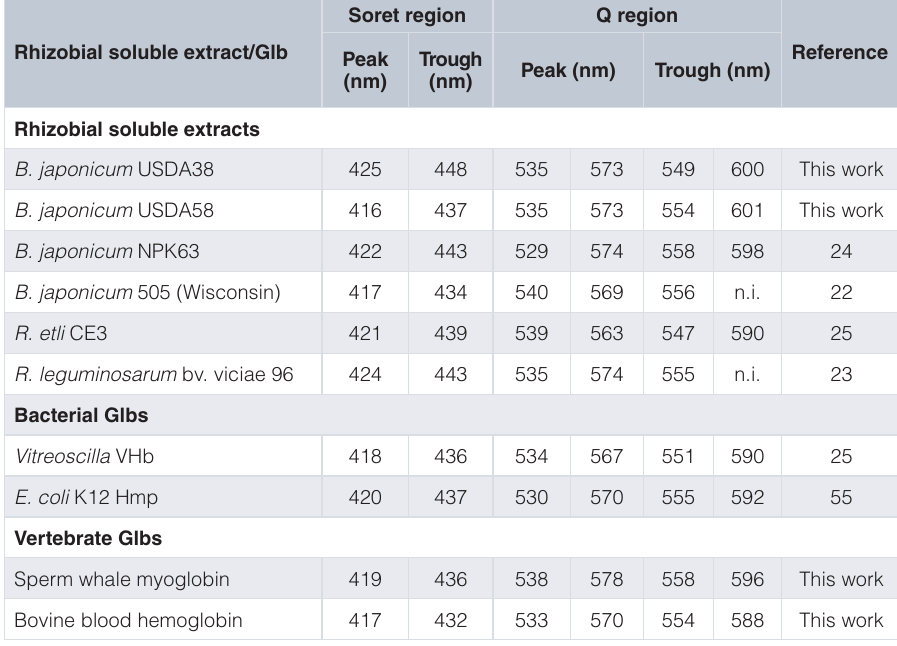
bovine blood hemoglobin are nearly identical. This preliminary evidence indicates that putative soluble Glbs are synthesized in B . japonicum USDA38 and USDA58. Interestingly, genes coding for SDgbs ( brajapUSDA38SDgb1 and brajapUSDA38SDgb2 ) and tHbs ( brajapUSDA38tHb1 and brajapUSDA38tHb2 ) were identi- fied in the B . japonicum USDA38 genome (Dataset 1). Thus, it is likely that putative B . japonicum USDA38 Glbs corresponds to a combination of SDgbs and tHbs. Inferences from the preliminary results reported here should be confirmed by Glb detection, isola- tion and unequivocal identification after protein sequencing. This may open the possibility to carry out further experimental analyses on rhizobial